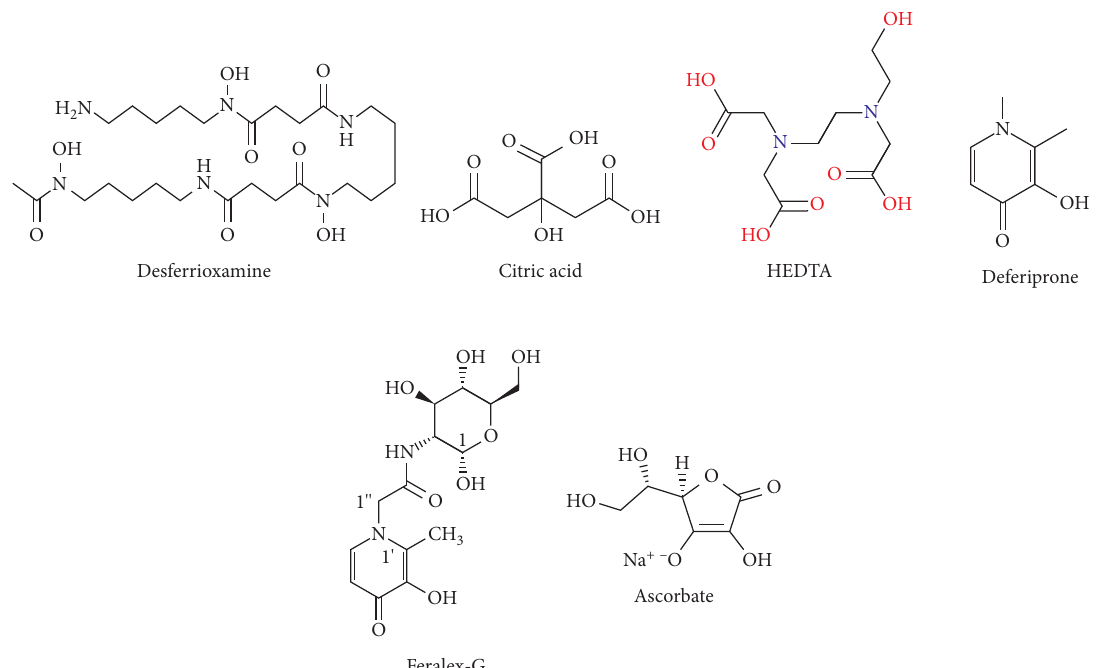
Figure 2: Aluminum chelators for the collection of aluminum deposits and reducing metal load in the